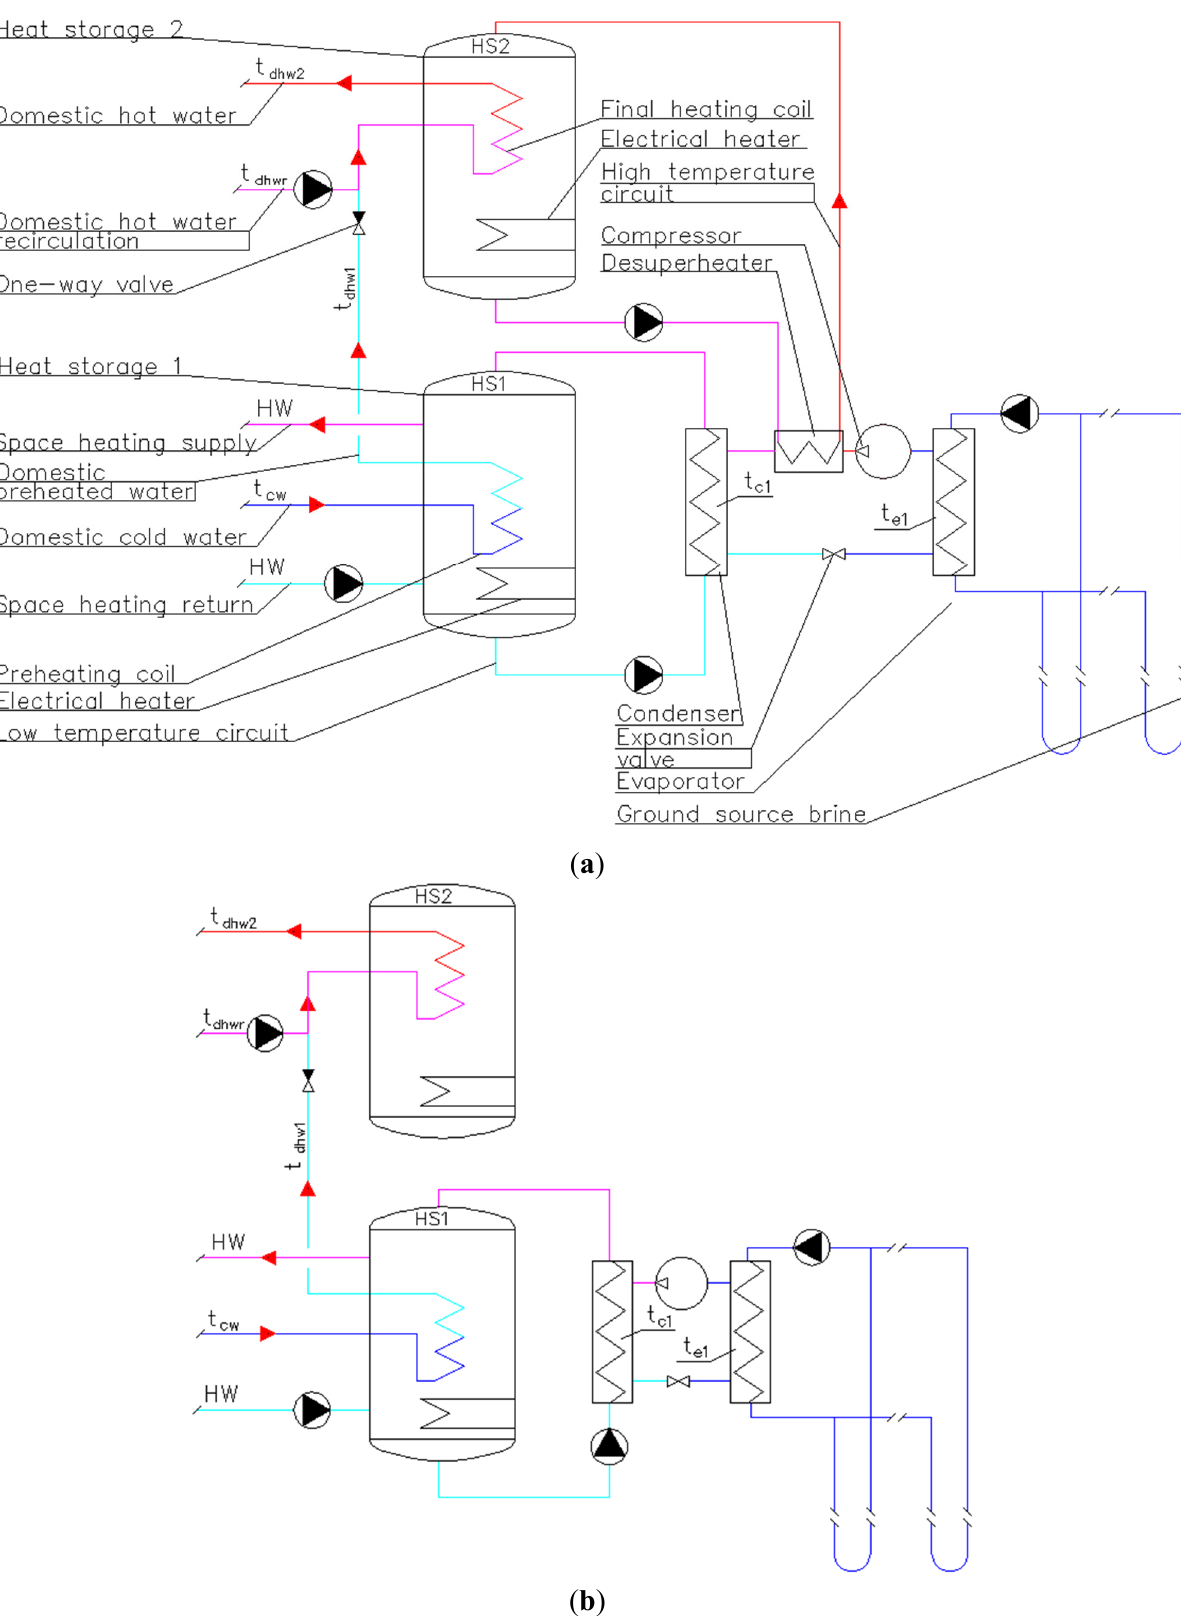
Figure 1. Domestic hot water (DHW) production: ( a ) System 1; and ( b ) System 2. System 4 is shown in Figure 2, on the right. One ground-source heat pump provides heat to HS1, and the other to